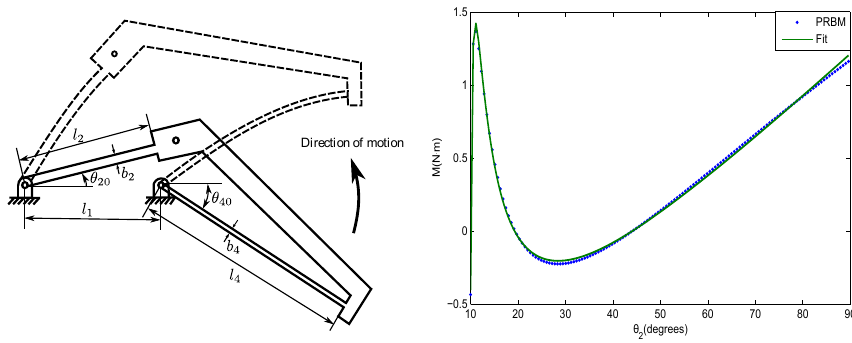
Figure 7. The structure of a Young bistable mechanism and its bistable kinetostatic behaviors. Table 2. Design parameters of a Young bistable mechanism. H is the out-of-plane thickness of the mechanism, E is the Young’s modulus of